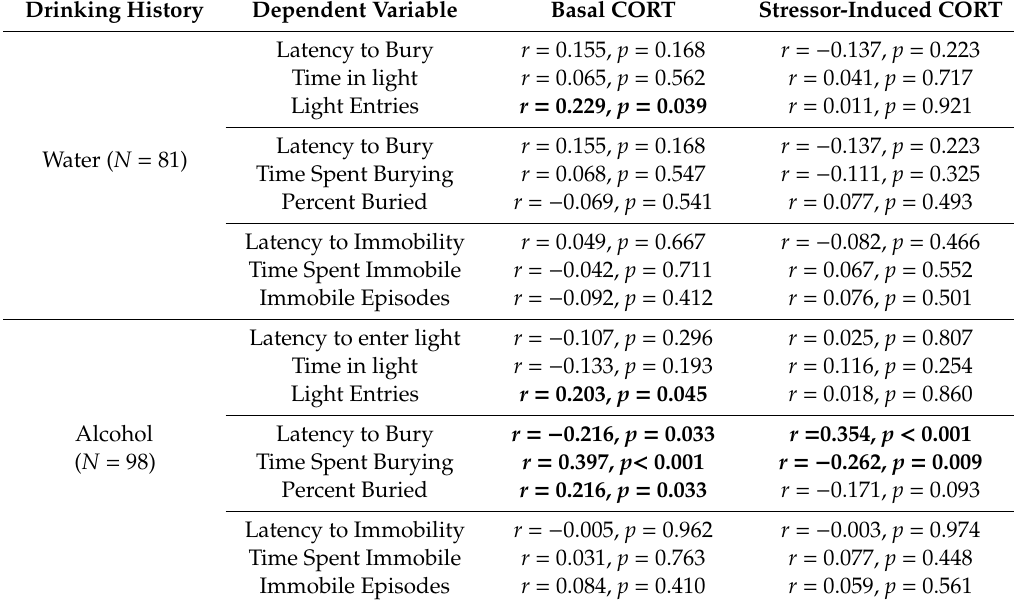
Table 1. Summary of the inter-relations between basal and stressor-induced increases in corticosterone (CORT) and our behavioral measures of negative a ff ect, deconstructed along the between-subjects factor of Drinking. Sample sizes are indicated in parentheses. Significant correlations are indicated in